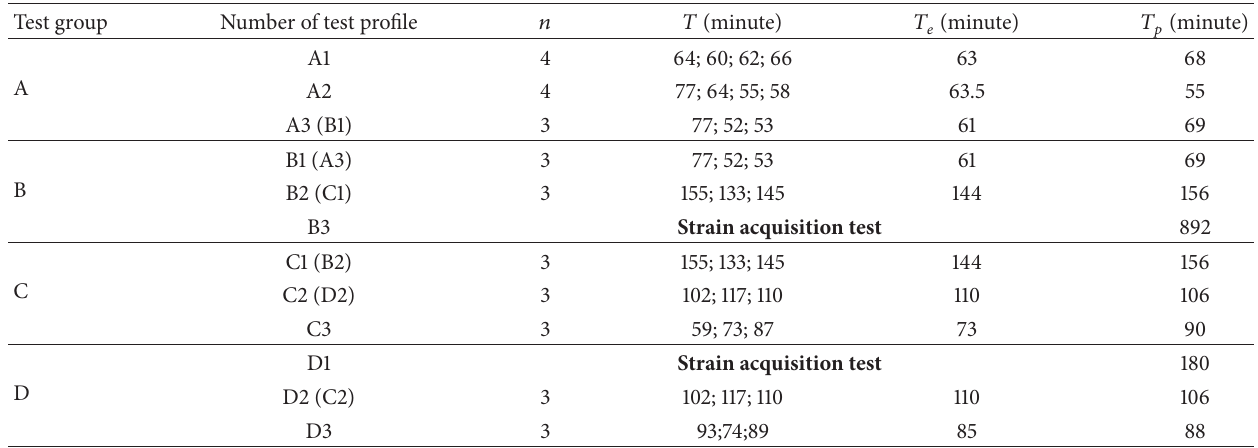
Table 6: Test matrix and results.